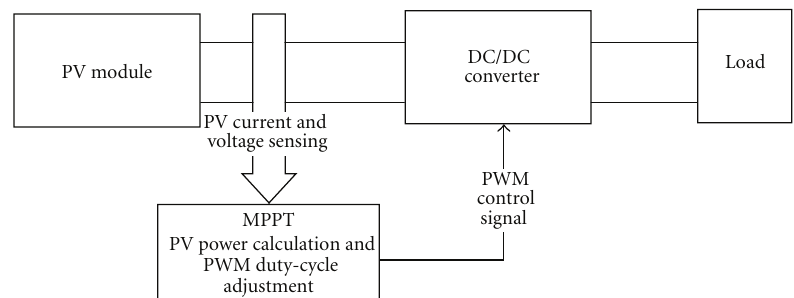
Figure 14: DC-DC converter for operation at the MPP.